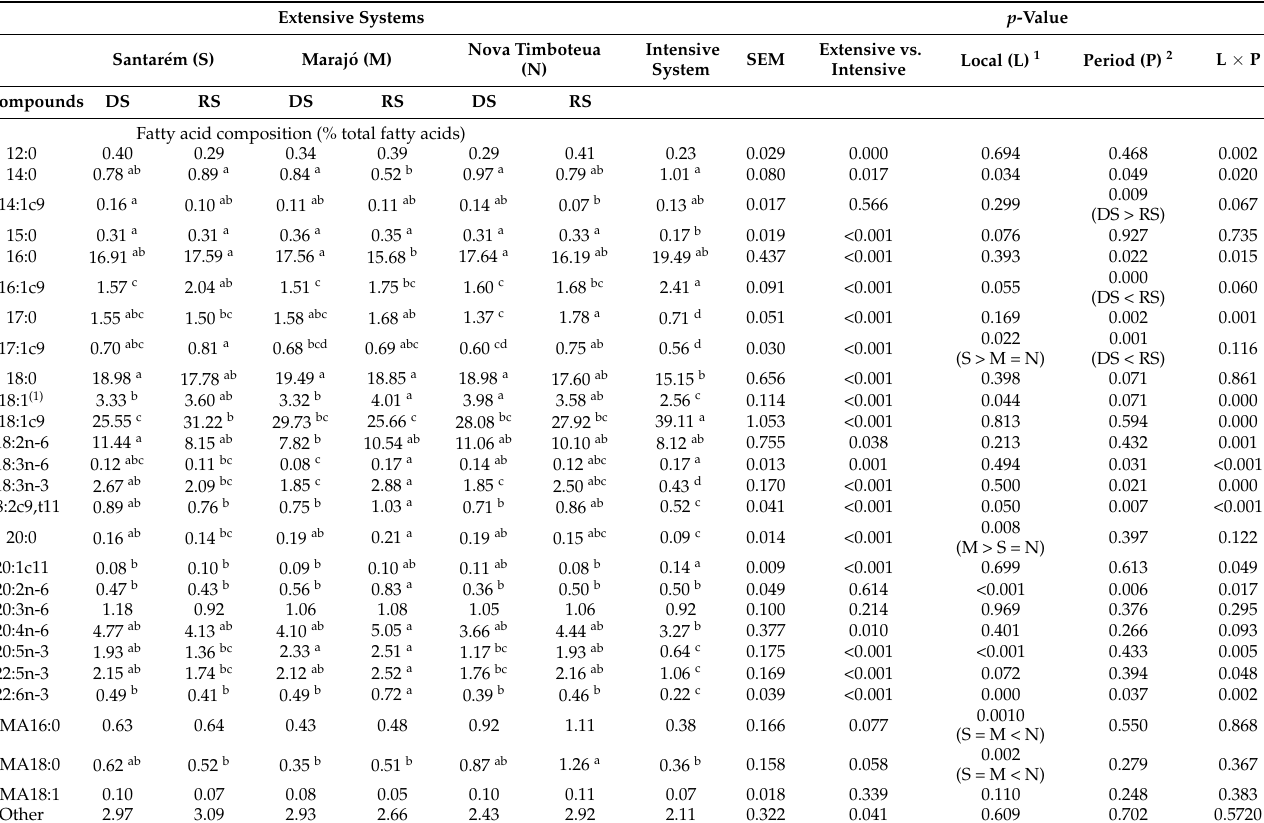
Table 3. Fatty acid composition of ribeye muscle of crossbred buffaloes ( n = 12) raised extensively in three types of production systems, during dry (DS) and rainy (RS) seasonal periods, or intensely in feedlots, in Eastern Amazonia